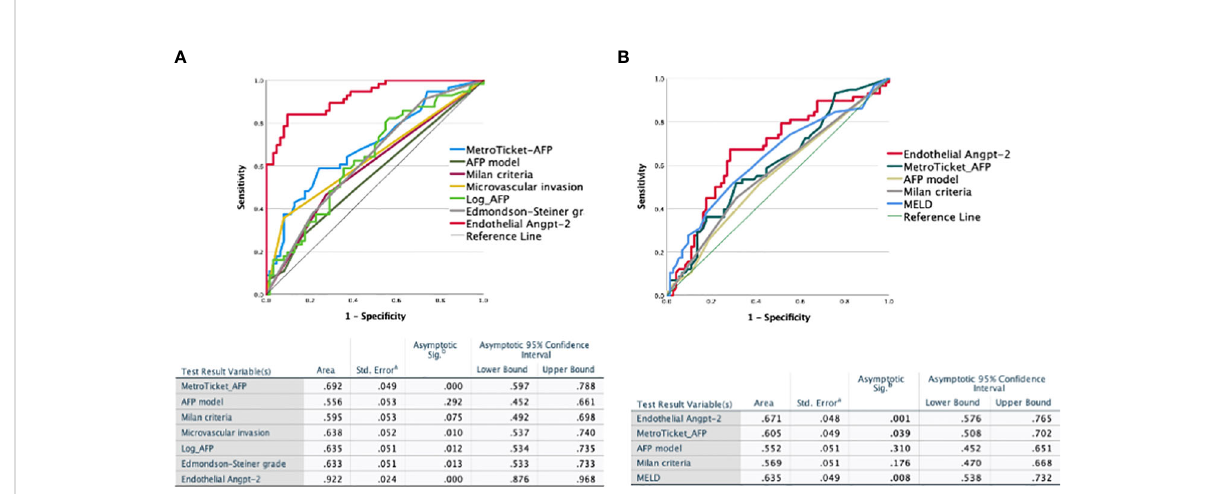
FIGURE 2 Receiver operating characteristic (ROC) analysis. Receiver operating characteristic (ROC) curves for the endothelial angiopoietin-2 and the different clinical scores for HCC recurrence (A) and survival (B) after liver transplantation in 140 matched transplanted HCC patients. angiopoietin-2 discriminating capacity was signi fi cantly higher than that of all clinical or pathologic scores for both recurrence (A) and survival (B)